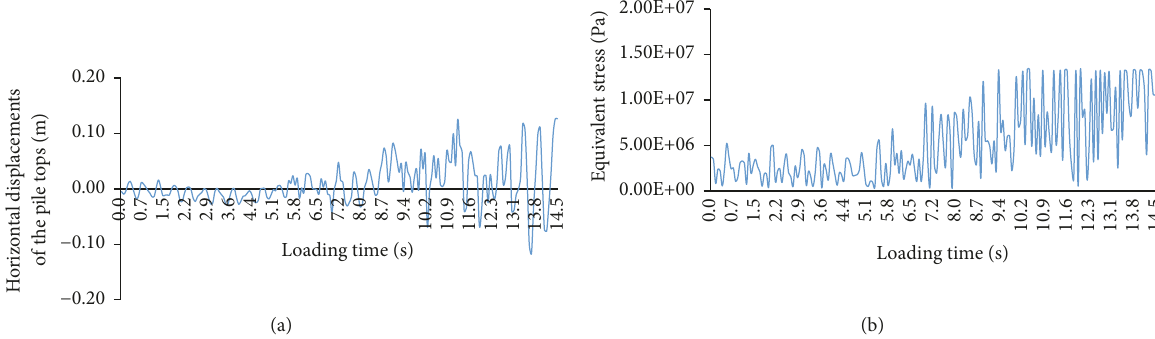
Figure 13: Displacement and equivalent stress time history curve of stabilizing piles. (a) The time history curve of displacement; (b) the time history curve of equivalent stress.